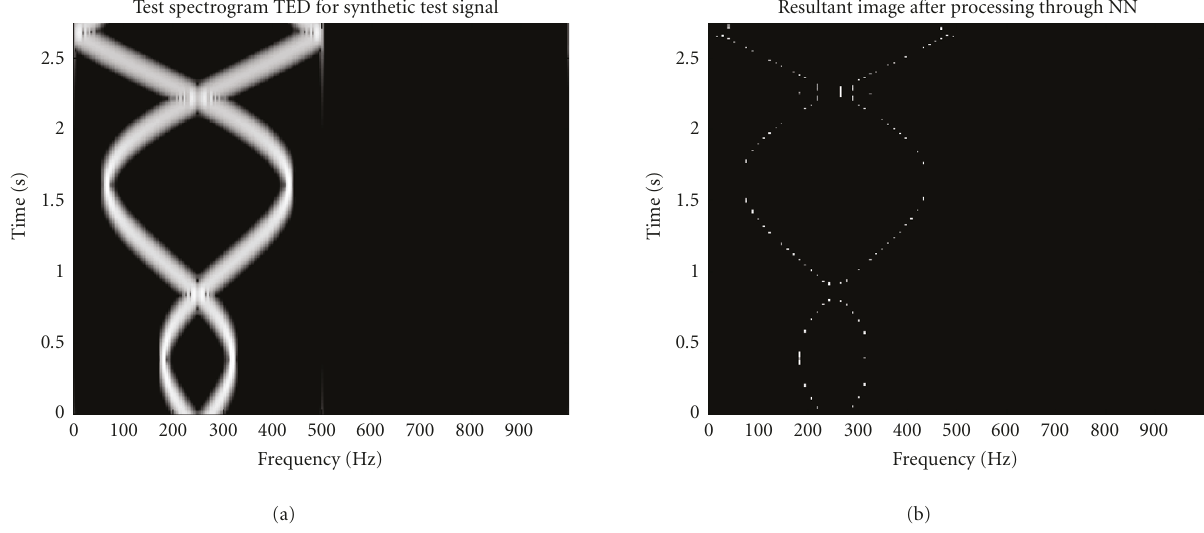
Figure 2: TFDs of a synthetic signal consisting of two sinusoidal FM components intersecting each other. (a) Spectrogram (TI 2) [Hamm, L = 90], and (b) NTFD.